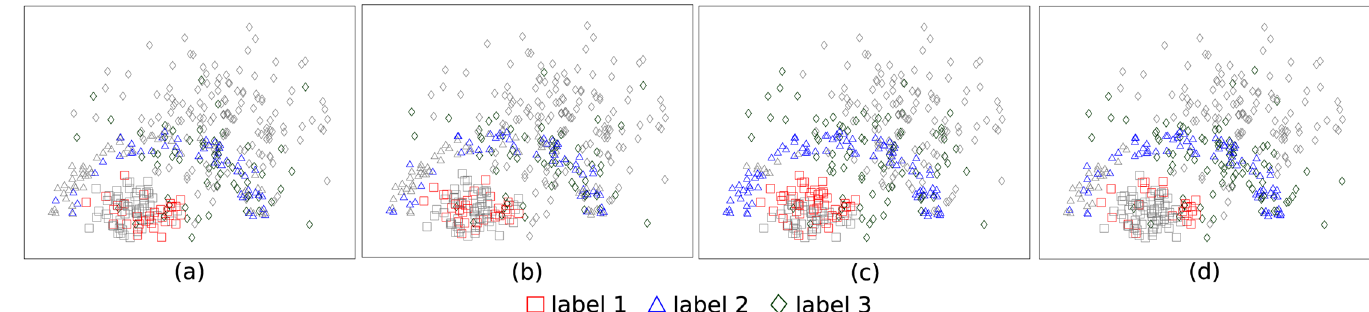
Fig 9. Selected samples by each classification model in the final training set, when using the Cone-Torus dataset and time limit of 1s. (a) k -NN. (b) OPF. (c) LSVM. (d) KSVM.